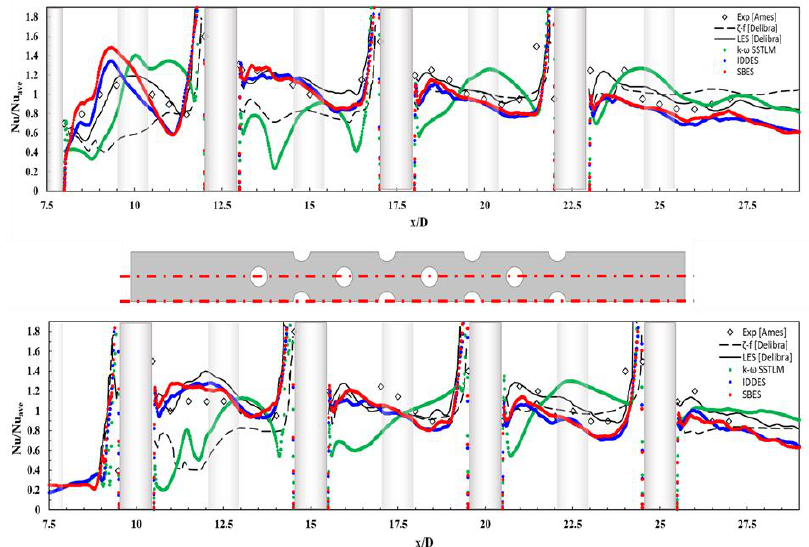
Figure 6. Local Nusselt number distributions normalized by surface average Nusselt numbers. ( A ) Middle line, ( B ) side line.